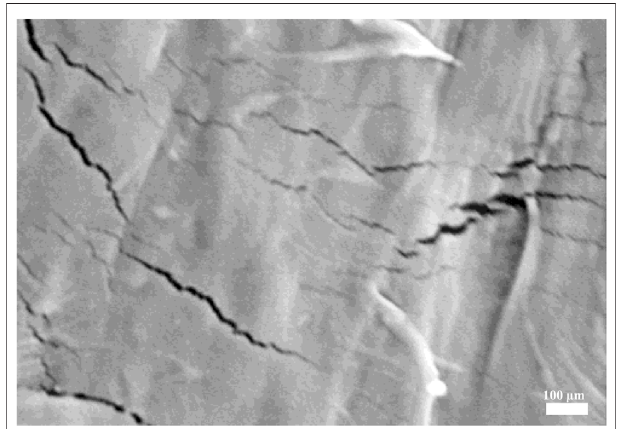
FIGURE8| High-densitypolyethylenegeonetsurfaceimageaftertensile testing.